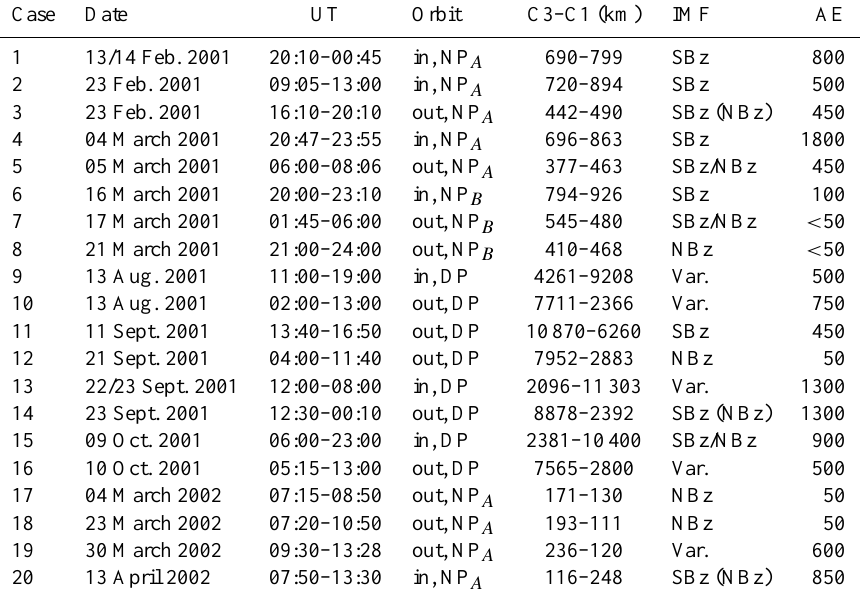
Table 1. Key characteristics of the investigated